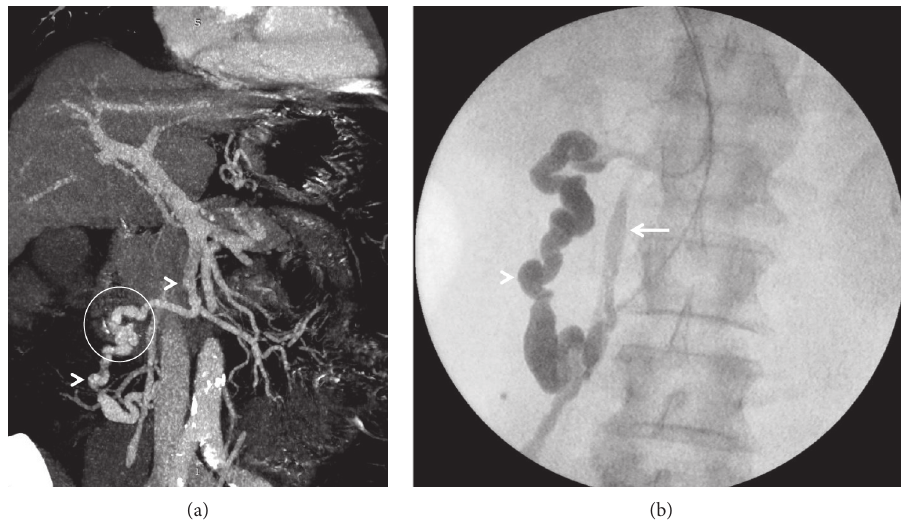
Figure 5: Coronal MIP image (a) depicting a right-sided mesogonadal shunt contributing to ectopic duodenal varices (encircled). Fluoroscopic spot image (b) showing the shunt which was accessed from the transjugular intrahepatic route and occluded with pushable metallic coils and n -butyl cyanoacrylate glue (not shown).